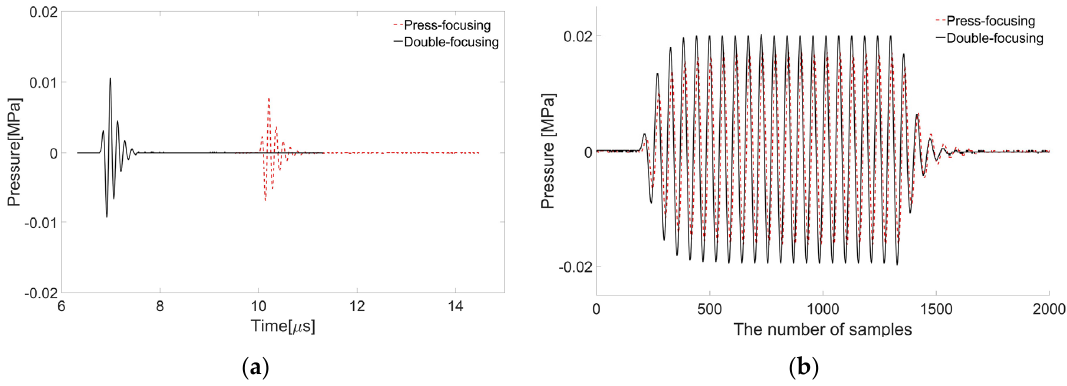
Figure 11. Waveforms measured by a hydrophone after delivering a 7-MHz sine wave with one cycle ( a ) and with 20 cycles ( b ) to each transducer. The maximum magnitude appeared at a depth of 15.2 mm in the case of the press-focused transducer (dotted line) and 10.2 mm in the double-focused transducer (solid line).